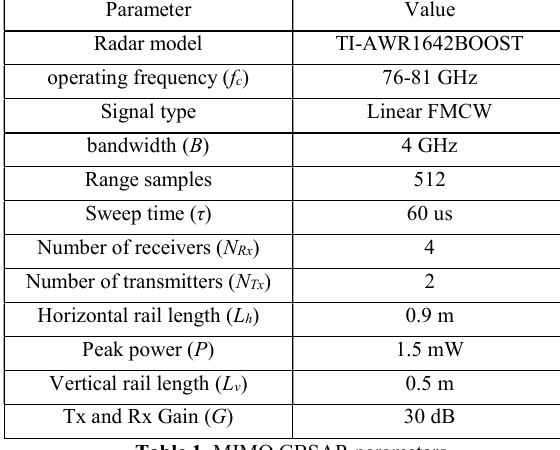
Table 1. MIMO GBSAR